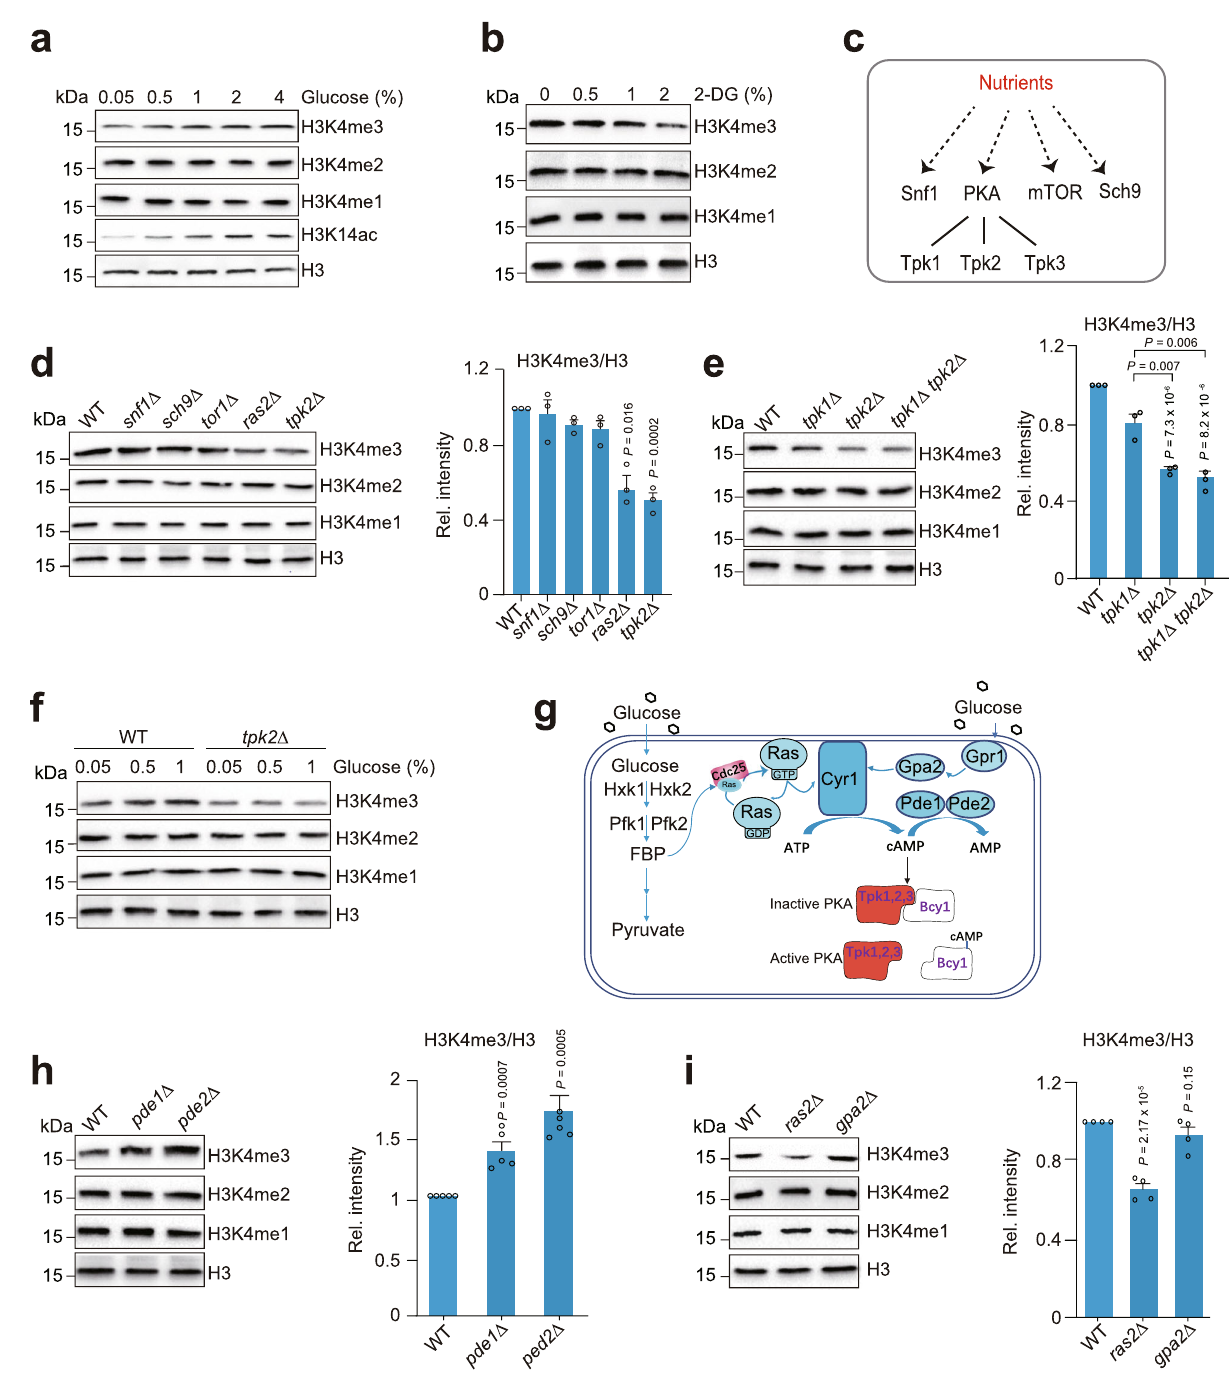
Fig. 1 | Glucose induces H3K4me3 via the Ras-cAMP-PKA pathway. a Effect of glucose on histone modi fi cations. Cellswere grown in YPD medium until OD 600 of 0.7 – 1.0 followed by treatment with YP medium supplemented with different con- centrations of glucose for 0.5hr. Cells were harvested and the extracted histones were analyzed by Western blots with indicated antibodies. b Effect of 2-Deoxy-D- glucose (2-DG) on H3K4 methylation. c Diagram showing nutrient sensors in bud- ding yeast. d Effect of nutrient sensors on H3K4 methylation. e Western blot ana- lysis of the effect of Tpk1 and Tpk2 on H3K4 methylation. f Tpk2 is required for